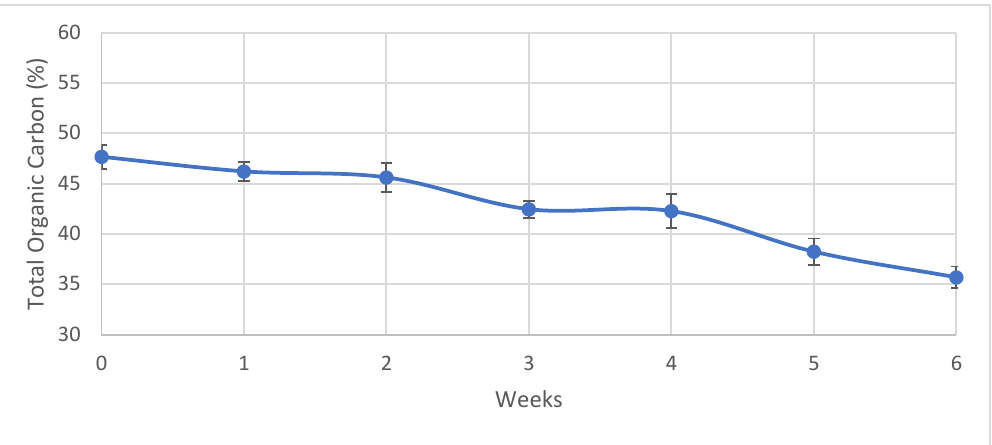
Figure 5. Corn cob waste total organic carbon behavior in pre-composting. During this process, it was observed that the concentration of TOC decreased due to the fact that it was utilized by microorganisms as a source of energy to carry out metabolic activities and the synthesis of cellular constituents [41].